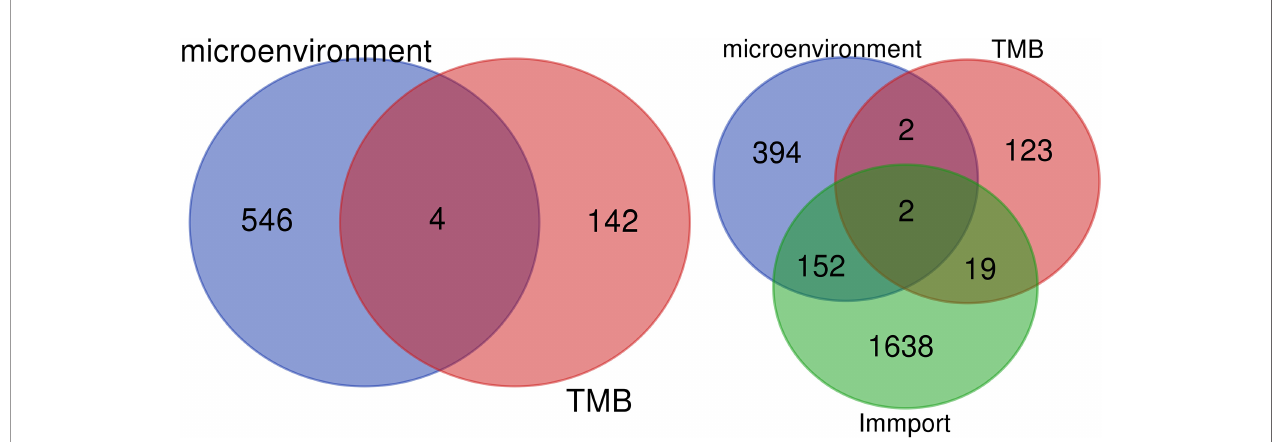
FIGURE 3 | We retrieved 2,498 immune-related genes from the ImmPort database and obtained a Venn map of the immune microenvironment, tumor mutational burden (TMB), and immune-related genes based on the informatics and Evolutionary Genomics